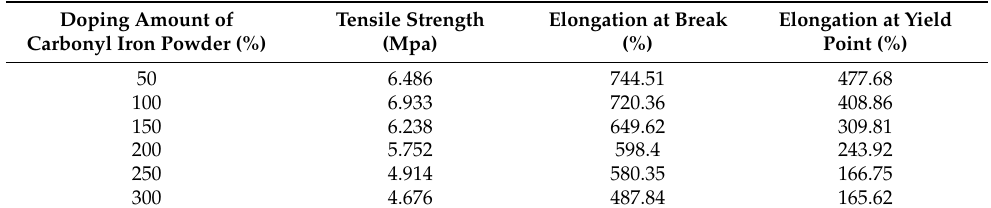
Table 3. The mechanical properties of the magnetic substrates with different contents of carbonyl iron powder.